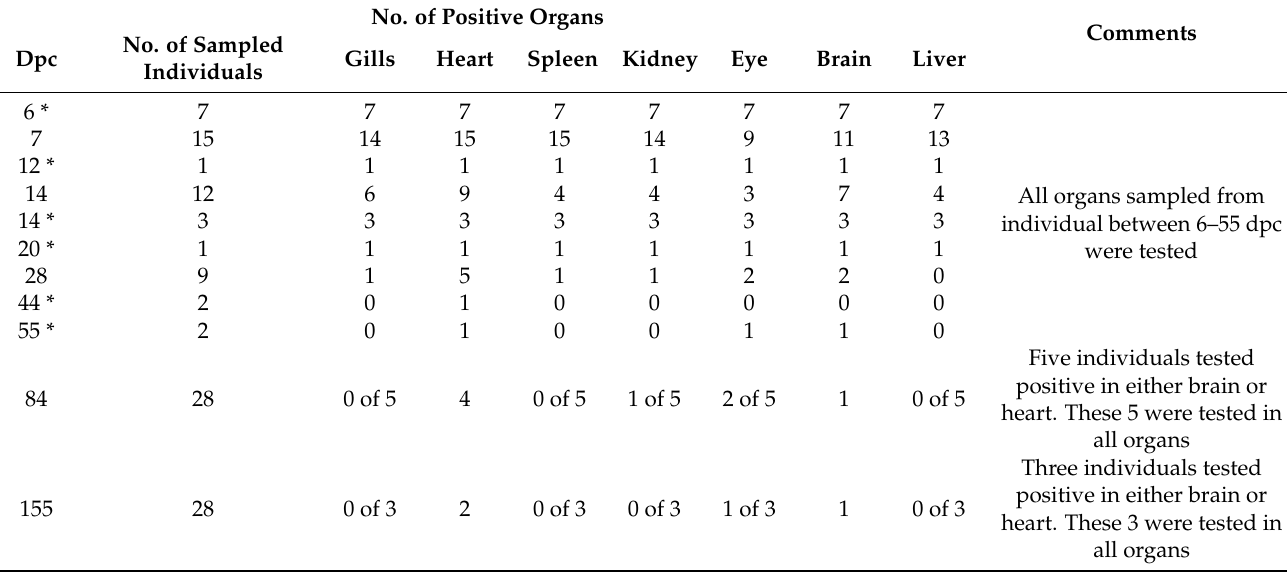
Table 2. Experiment 1, intra peritoneal injection: Number of positive VHSV detections by rRT-PCR. Organ samples from five fixed sampling points (7, 14, 28, 84, 155 dpc) in addition to sampling of clinically-affected fish and resent mortalities (*). Dpc = days post